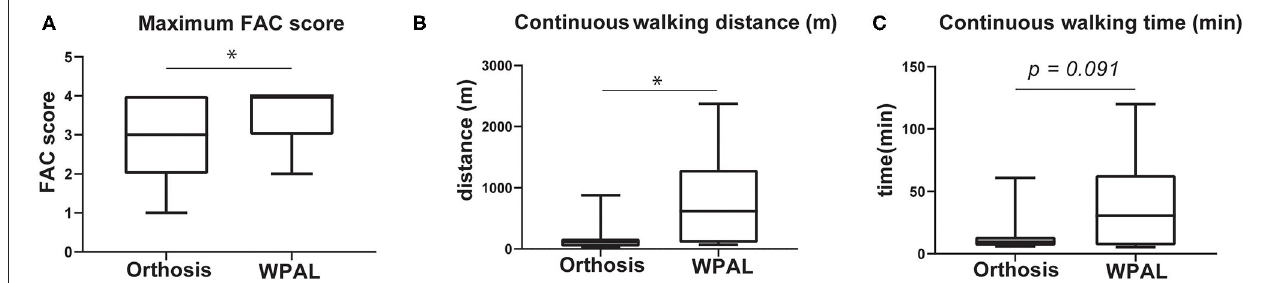
FIGURE 3 | Comparisons of gait performance between the conventional orthosis and the WPAL. (A) Maximum FAC score, (B) continuous walking distance, and (C) continuous walking time. Each box represents 25–75% percentile and whiskers represent 5–95 percentile. Asterisk indicates statistically significant differences ( p <